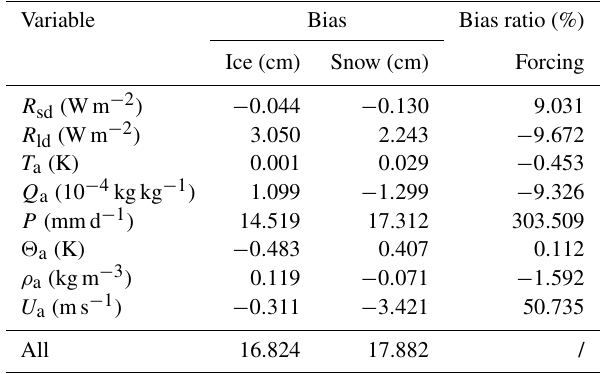
Table 3. Bias of ice thickness, snow depth, and bias ratio for each forcing variable from Table 2. “All” means using the full set of ERA5 atmospheric